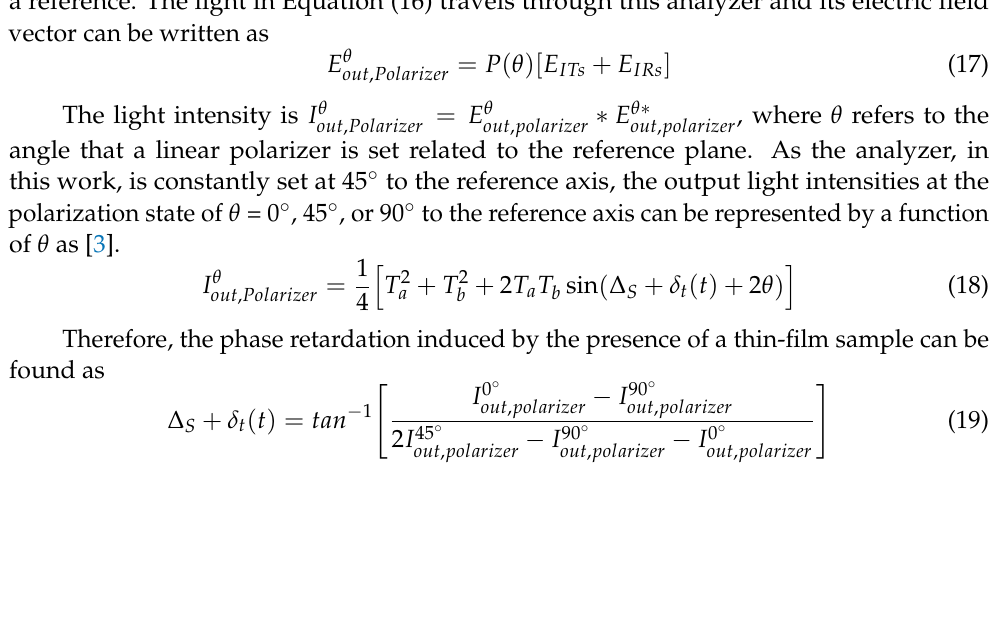
Figure 3. Schematic of the proposed modified Sagnac interferometer with the presence of samples.